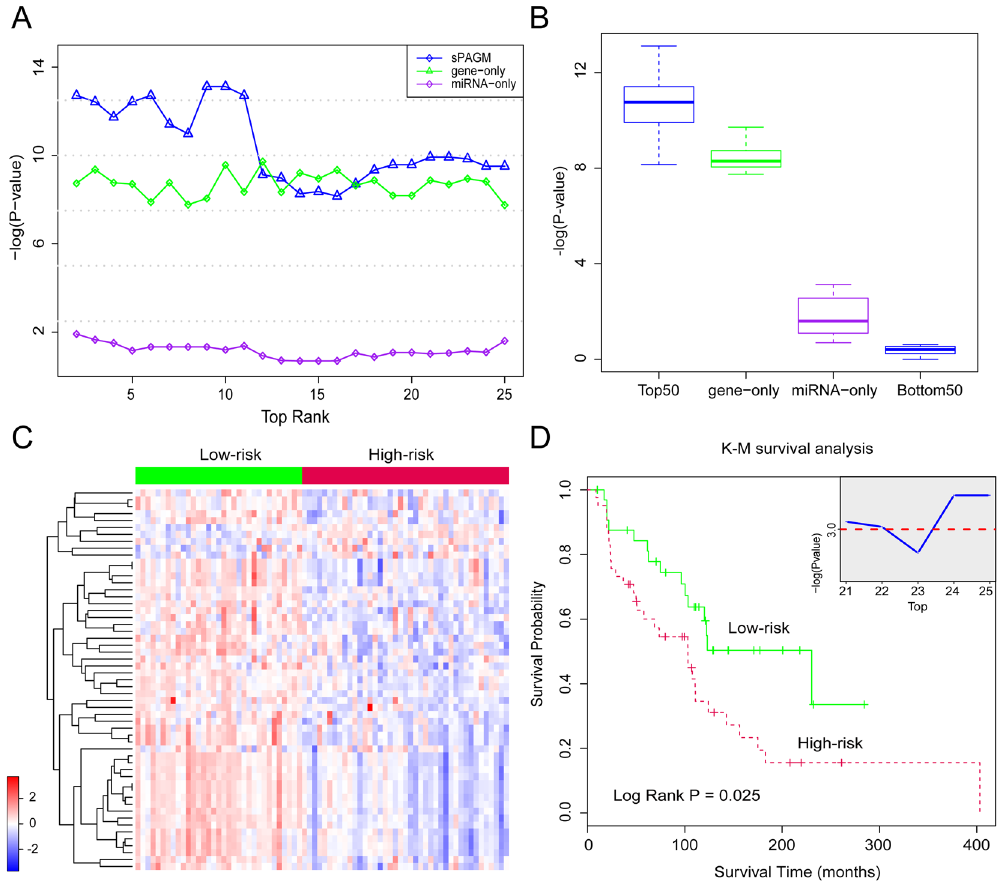
Figure 4. A comparison of methods and survival verification. ( A ) A comparison of the sPAGM model, and gene-only and miRNA-only methods using the top 25 subpathways. ( B ) A further comparison of methods when increasing the top rank value. ( C ) A K-mean clustering representation of the subpathway signatures in the independent data set. The columns include 74 tumor samples and the rows include 55 subpathways. The red colors designate high subpathway activity, and the green color designates low activity. ( D ) A K-M plot of the low risk and high risk groups. The P -value was calculated using the log-rank test. Other subpathway signatures with ranks < 25 were also